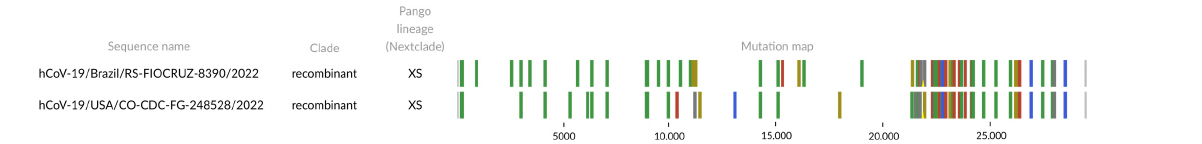
Figure A1. Mutational patterns of the Brazilian and the XS recombinants (Nextclade’s output). The Brazilian recombinant was initially identified as an XS lineage, although the portion between the positions 1 and 20,000 diverged from the XS archetype.